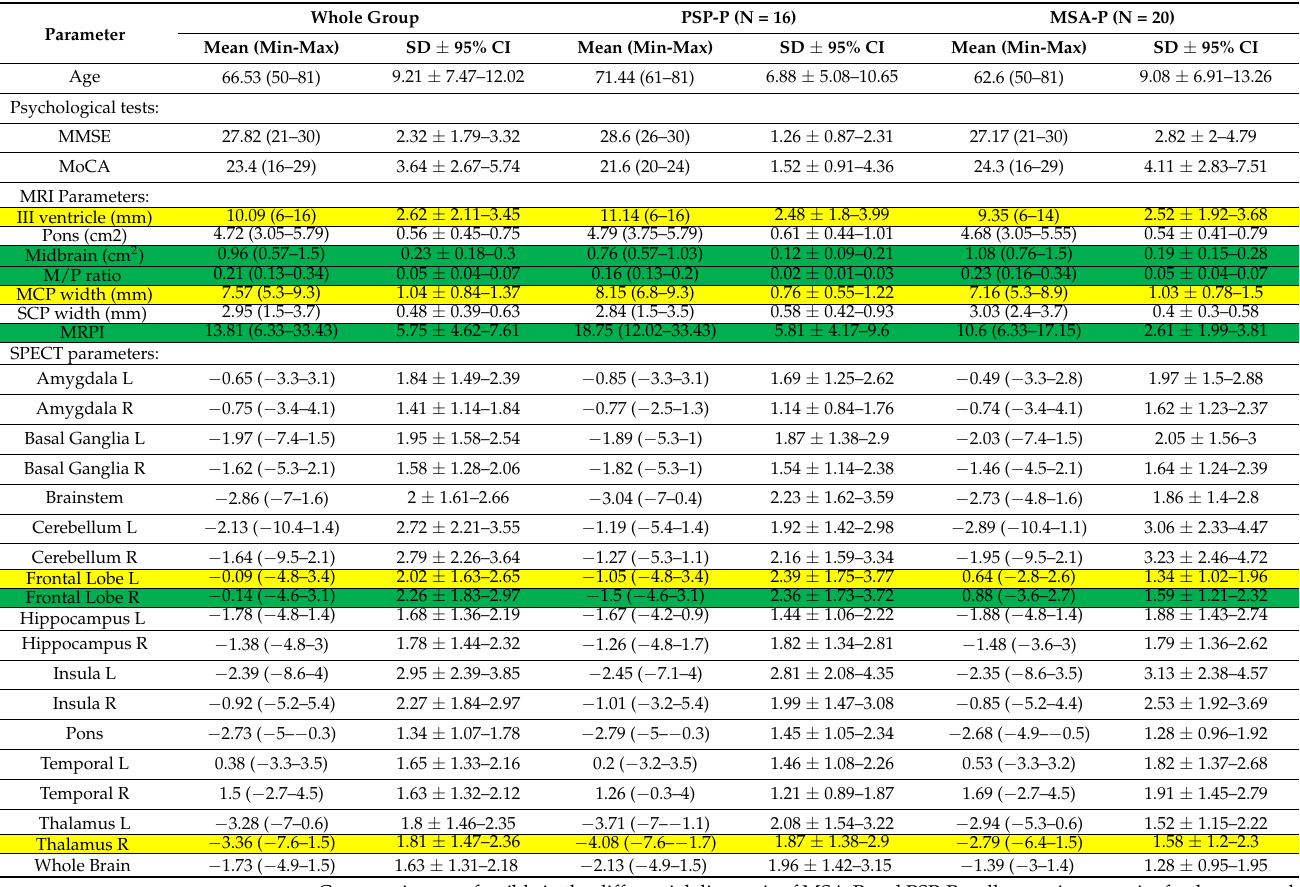
Table 1. Basic statistics for research group and